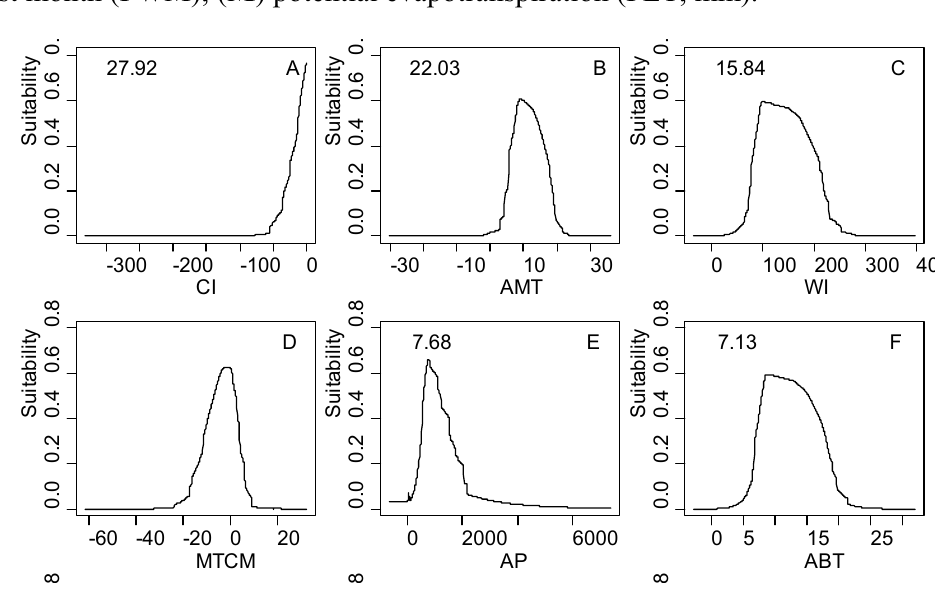
Figure S1. The response curves of climatic habitat suitability values for all climatic factors based on the MaxEnt model decreasing in order based on their relative importance (shown in the upper-left corner of each subplot); ( A ) Coldness index (CI, °C); ( B ) annual mean temperature (AMT, °C); ( C ) warmth index (WI, °C); ( D ) mean temperature of the coldest month (MTCM, °C); ( E ) annual precipitation (AP, mm); ( F ) annual biotemperature (ABT, °C); ( G ) precipitation of driest month (PDM, mm); ( H ) mean temperature of the warmest month (MTWM, °C); ( I ) precipitation of seasonality (PSD, mm); ( J ) humidity index (HI, mm/°C); ( K ) annual range of temperature (ART, °C); ( L ) precipitation of wettest month (PWM); ( M ) potential evapotranspiration (PET,